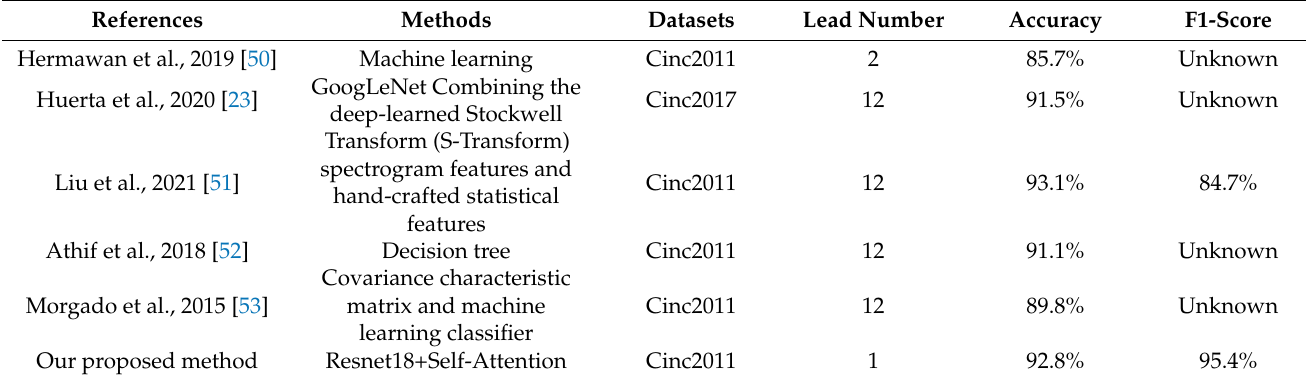
Table 5. Performance metrics between the model proposed in this study and various common networks are